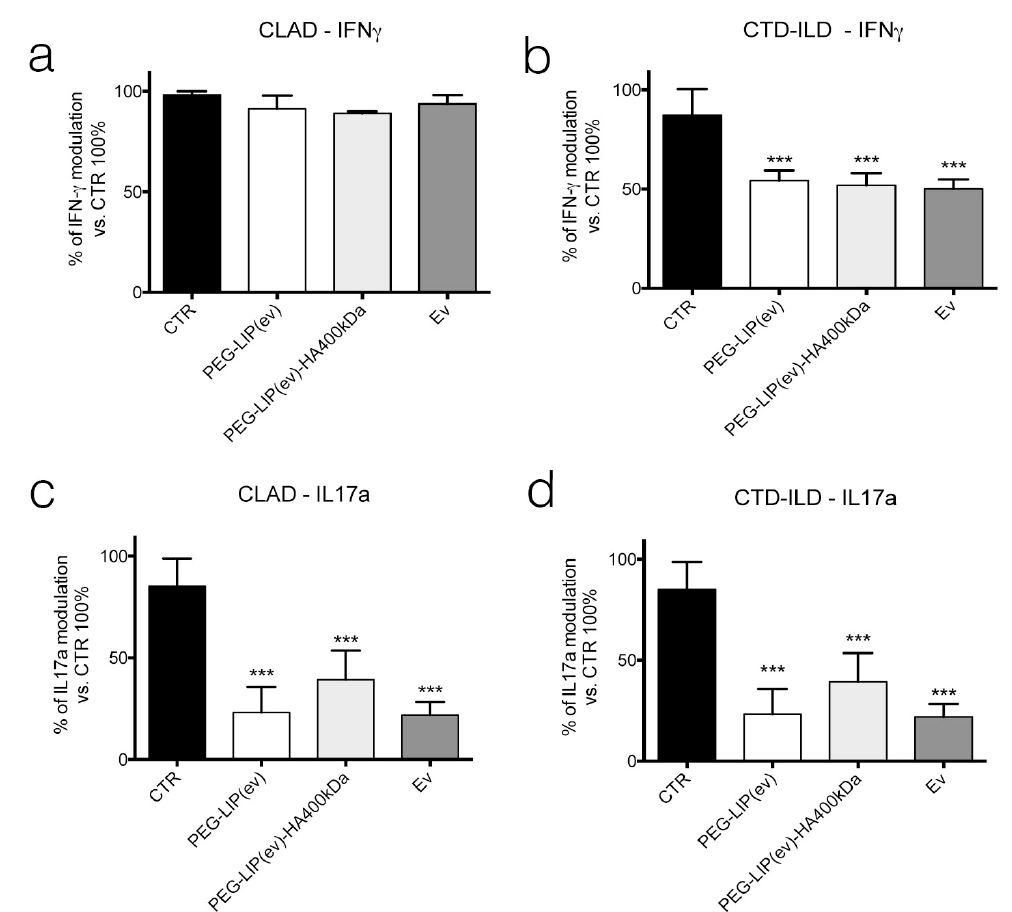
Figure 10. Evaluation of IFN- γ and IL17a release from CD3 + lymphocytes derived from peripheral blood of ( a , b ) CLAD and ( c , d ) CTD-ILD patients after treatment with PEG-LIP(ev), PEG-LIP(ev)-HA400kDa and Ev (50 nM). Data are represented as mean ± SD of number of spots normalized to CTR set at 100%. ***, p < 0.001 vs. CTR.